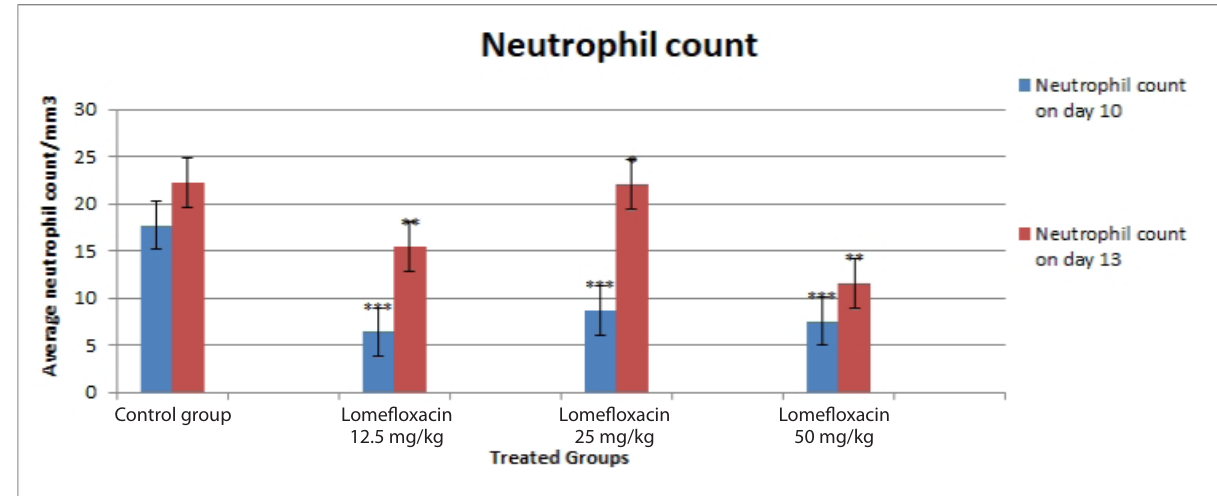
FIGURE 2 (D ) - Neutrophils count before and after cyclophophamide